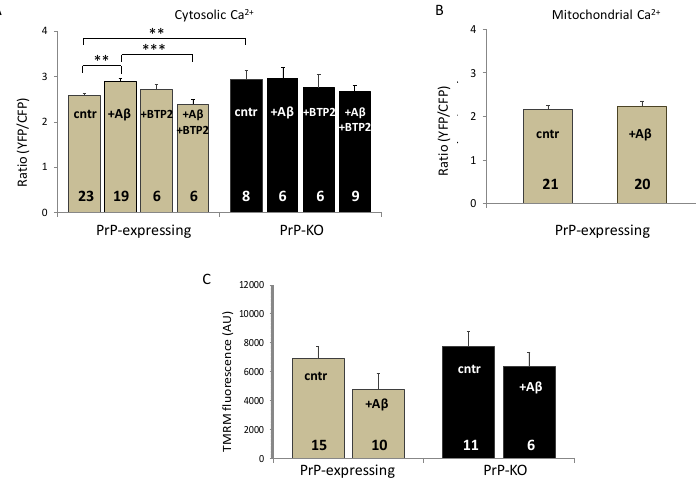
Figure 2. Soluble A β 1–42 oligomers abrogate the PrP-dependent regulation of resting cytosolic Ca 2 + but does not a ff ect mitochondrial Ca 2 + levels and membrane potential in PrP-expressing primary cortical neurons. ( A ) Incubation with soluble A β 1–42 oligomers ( + A β ) increases resting cytosolic Ca 2 + in PrP-expressing cortical neurons but not in PrP-KO neurons, nullifying the di ff erence observed between the two untreated genotypes (cntr). While preincubation with the SOCE inhibitor N -{4-[3,5-bis(Trifluoromethyl)-1 H -pyrazol-1-yl]phenyl}-4-methyl-1,2,3-thiadiazole-5-carboxamide ( + BTP2, 200 nM) leaves una ff ected basal cytosolic Ca 2 + in untreated cells, and it reverts the A β e ff ect in PrP-expressing neurons ( + A β , + BTP2), upregulation of SOCE is the likely responsible for the A β -induced higher basal Ca 2 + levels. ( B ) Conversely, A β does not a ff ect Ca 2 + levels in mitochondria of PrP-expressing neurons. Bar diagrams of panels A and B report the ratio between the FRET-acceptor (yellow fluorescent protein, YFP) and -donor (cyan fluorescent protein, CFP) fluorescence intensities of the used cameleon Ca 2 + probe (D1cpv and 4mtD3cpv [71] in the cytosol and in the mitochondrial matrix, respectively). For these measurements, four days after isolation and plating, neurons were transduced with adeno-associated virus (AAV) coding for the chameleon bearing no targeting sequence ( A ), or a sequence directing the probe to the mitochondrial matrix ( B ), under the control of the pan-neuronal hSyn promoter [75]. Two days after infection, neurons were mounted into an open-topped chamber and maintained in 1 mM CaCl 2 -containing Krebs-Ringer bu ff er kept at 37 ◦ C using a temperature-controlled apparatus (TC-324B, Warner Instruments). FRET measurements and analysis were performed as previously reported [75]. ( C ) No statistical variation is observed between the mitochondrial membrane potential of untreated, or A β -treated, PrP-expressing, and PrP-KO neurons. Here, the bar diagram reports the relative fluorescence quantification of the membrane potential-sensitive probe tetramethylrhodamine methyl ester (TMRM, Molecular Probes) [46] in experiments carried out with neurons loaded with TMRM (20 nM, 30 min, 37 ◦ C) in the presence ( + A β ), or in the absence (cntr), of A β 1-42 oligomers. ** p < 0.01, *** p < 0.001 (Student (cid:48) s t -test). AU (arbitrary units). Other details are as in the legend to Figure